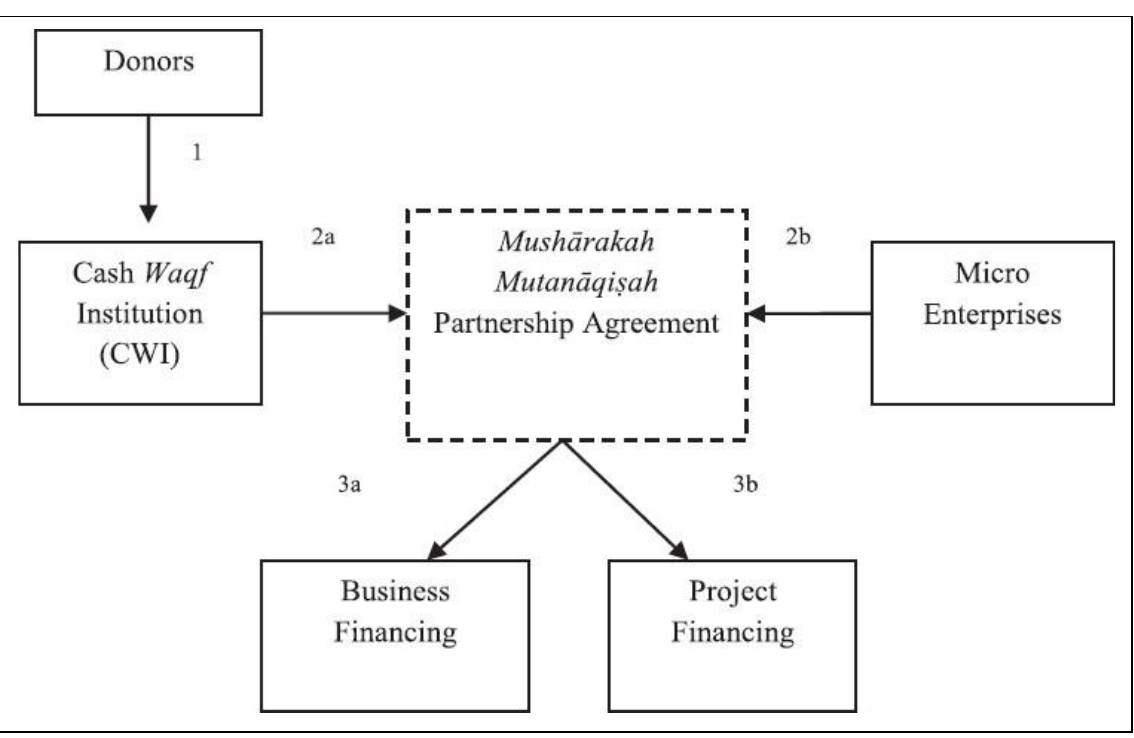
Figure 1: Micro Business Financing through Cash Waqf with the Musyarakah Mutanaqisah